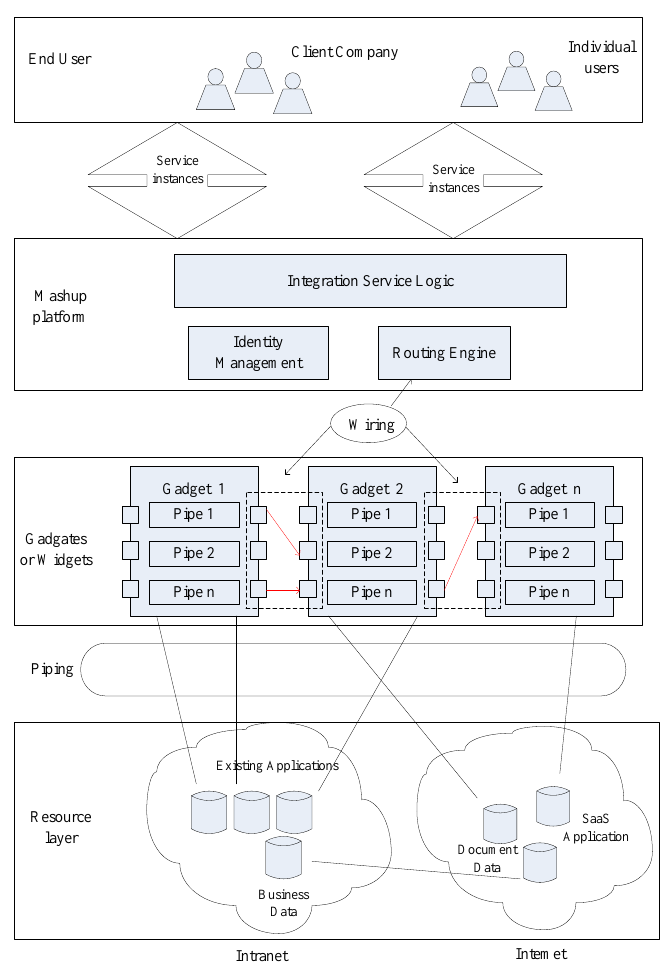
Figure 2. The Services Mashup for Cloud Computing